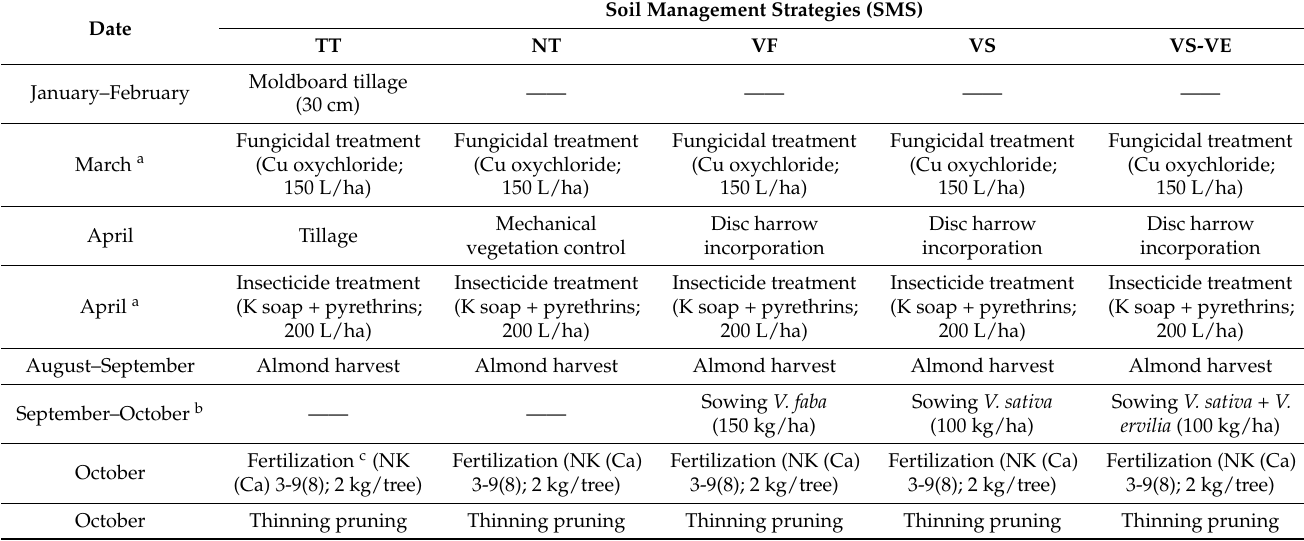
Table 2. Soil management strategies applied in almond organic production system during study period